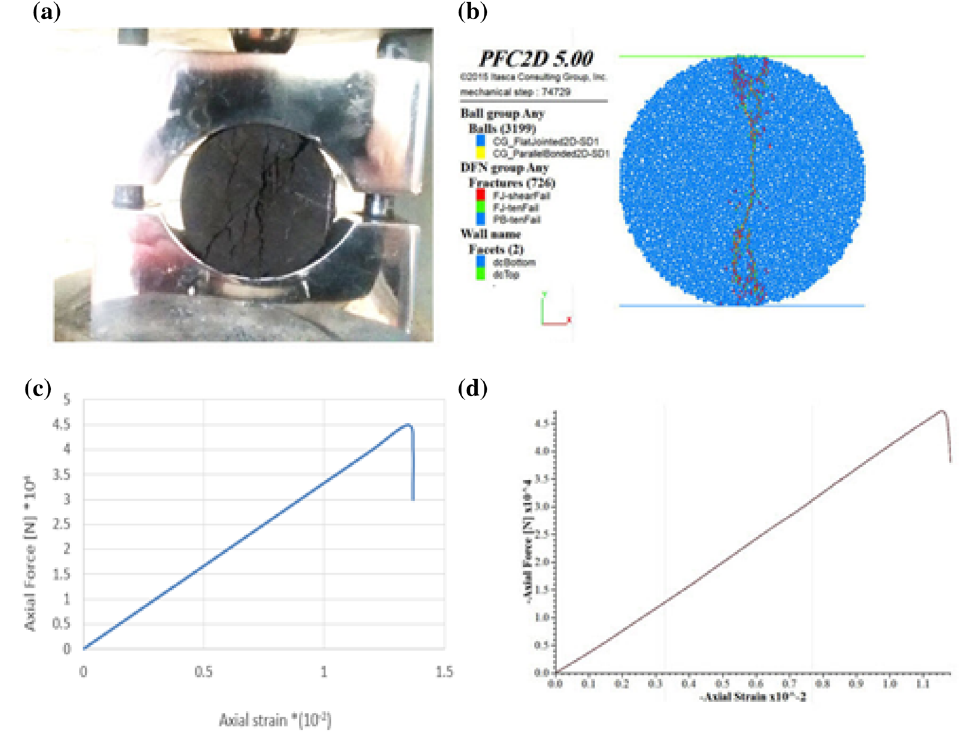
Fig. 5 Failure pattern in a experimental test, b numerical simulation, c stress-strain curve in experimental test, d axial force versus axial strain in numerical model